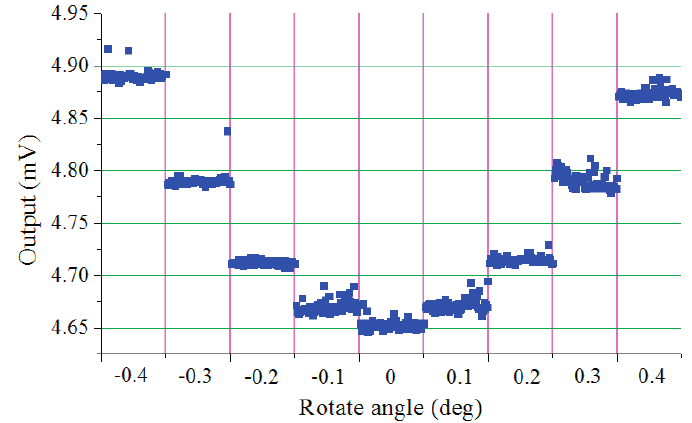
Figure 8. Testing the resolution of the